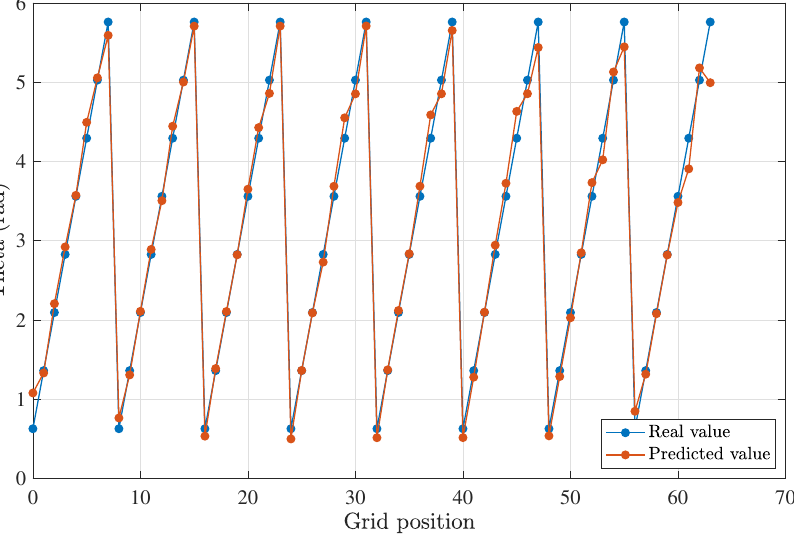
Figure 18. Comparison between the predicted and expected offset angle for a Tx–Rx distance of